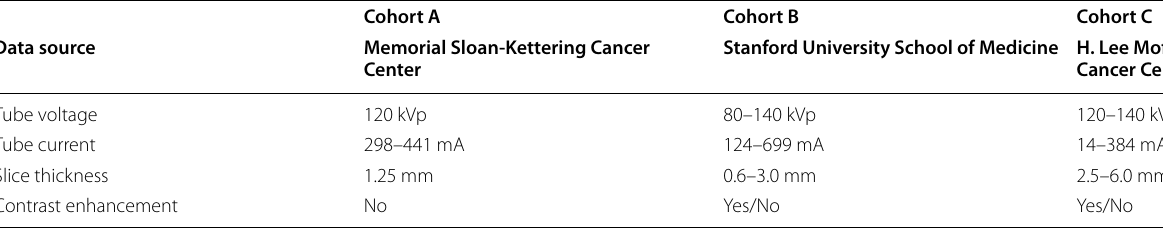
Table 3 CT image acquisition protocols